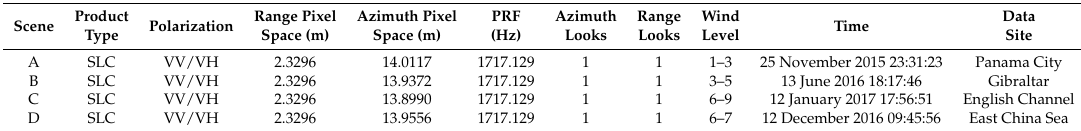
Table 2. Parameters of the Sentinel-1